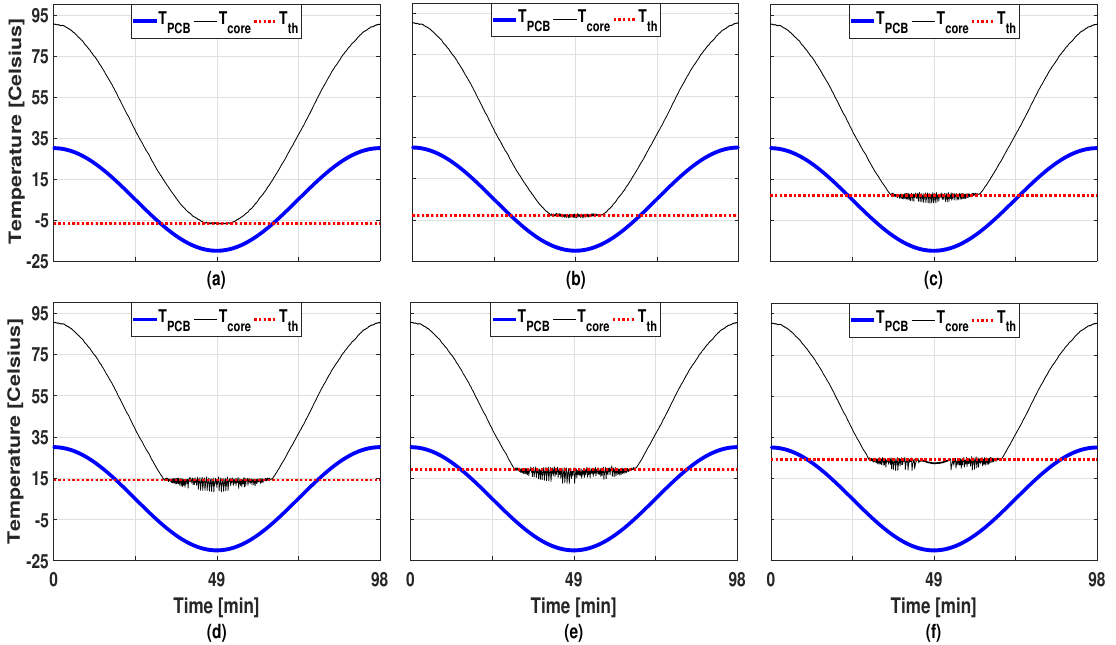
Figure 5. Temperature profiles asb of T core [ 0 ] with the proposed technique using virtual tasks and DVFS under different power constraint: ( a ) 4.02 W, ( b ) 4.08 W, ( c ) 4.34 W, ( d ) 4.59 W, ( e ) 4.81 W, and ( f ) 5.00